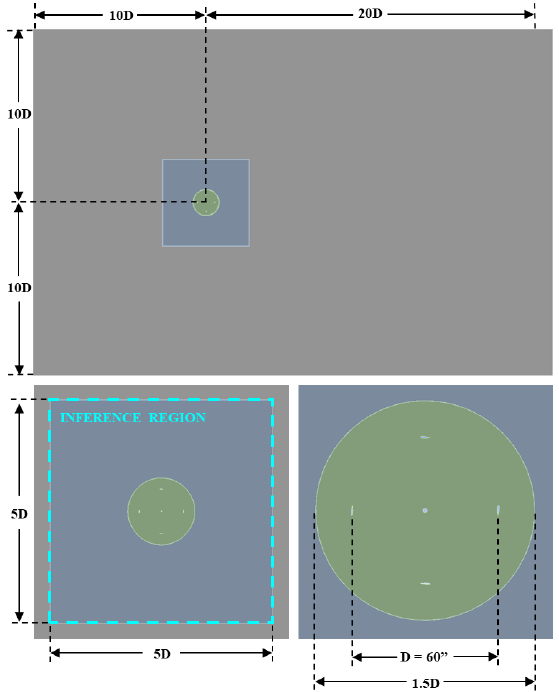
Figure 1. Flow domain geometry with a demarcated inference region. The division of the flow domain into discrete zones serves three important